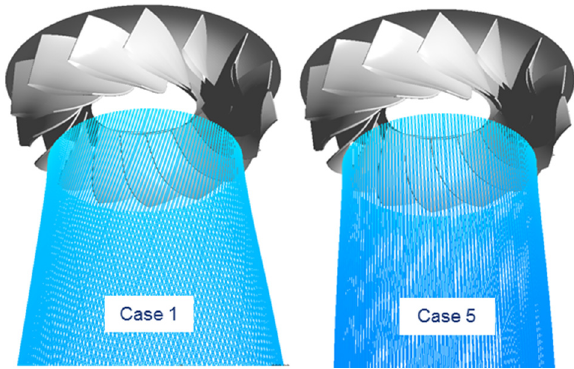
Figure 12. Streamline distribution in draft tube.